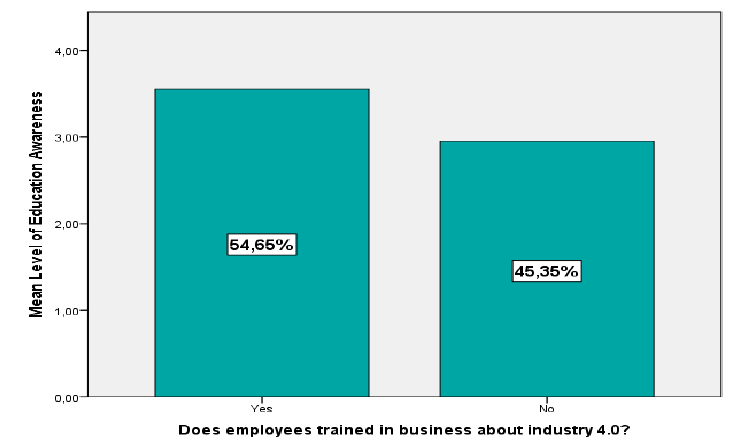
Fig. 3. Employees receive training on industry 4.0